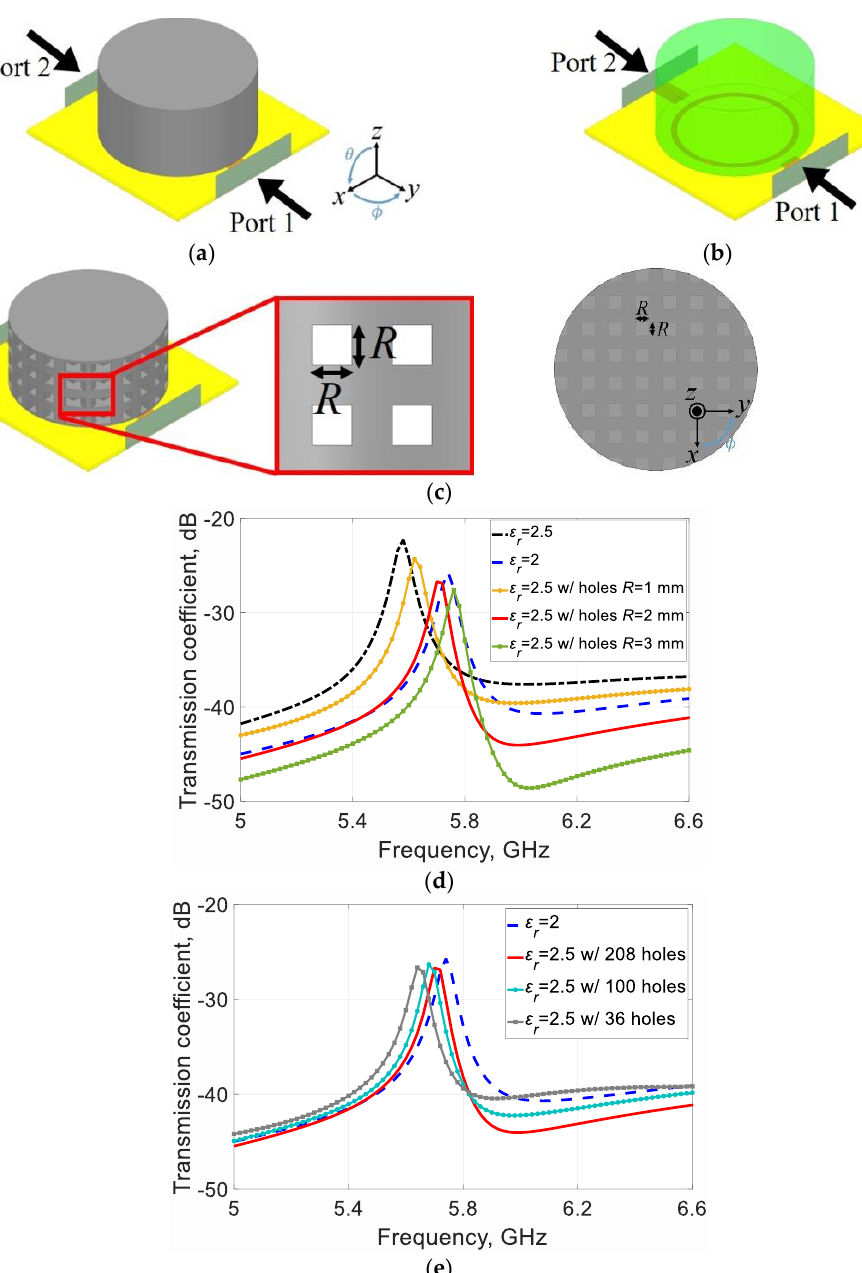
Figure 4. Ring resonator simulation. ( a ) Setup with a sample of 𝜀 𝑟 = 2.5. ( b ) Setup with a sample of 𝜀 𝑟 = 2. ( c ) Setup with a sample of 𝜀 𝑟 = 2.5 with holes. ( d ) Transmission coefficient according to R . ( e ) Transmission coefficient according to the number of holes .